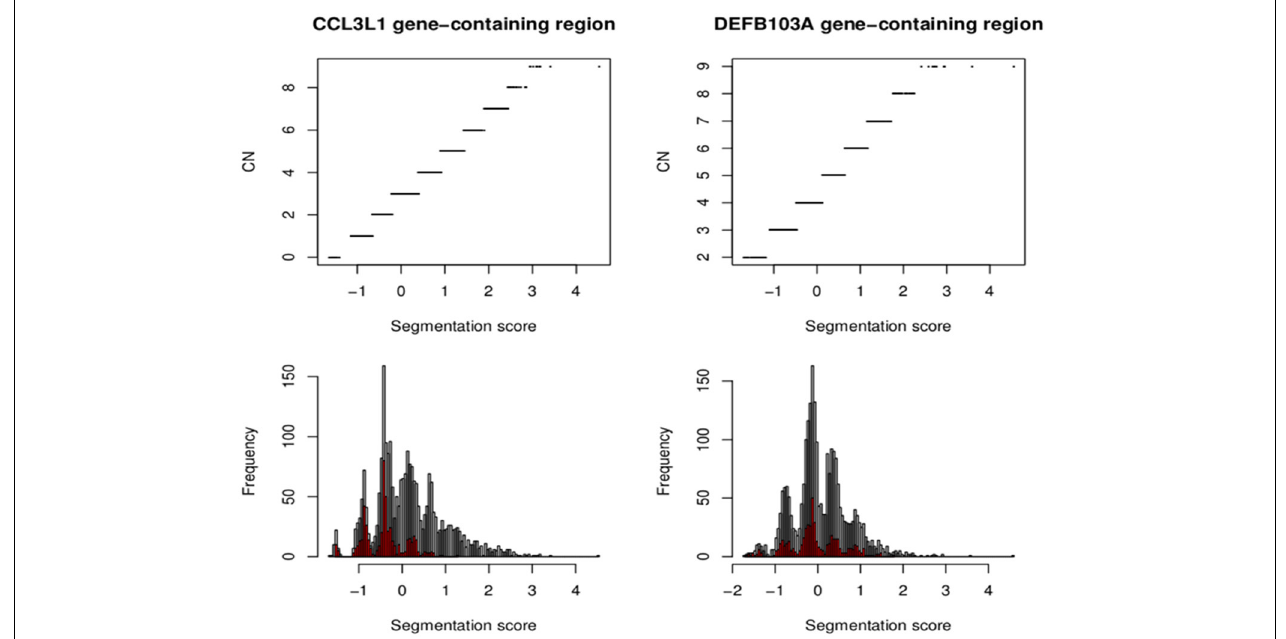
FIGURE 9 | Segmentation scores and CN groups at the CCL3L1 and DEFB103A loci. Segmentation scores of all populations (bottom). Small populations (European for CCL3L1 and South Asian for DEFB103A) are in red. The top pictures show segmentation scores and their CN groups.